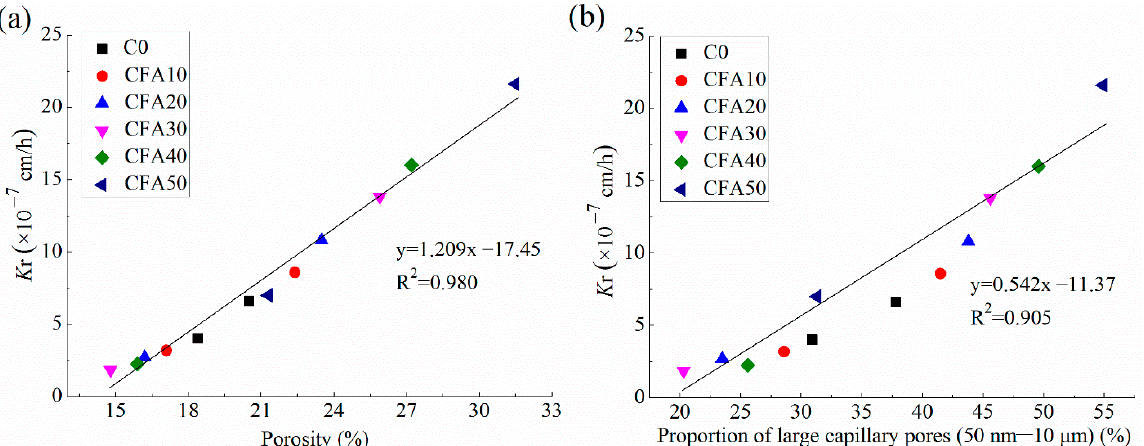
Figure 4. The relationship between the relative permeability coefficient K r and ( a ) porosity and ( b ) proportion of large capillary pores.